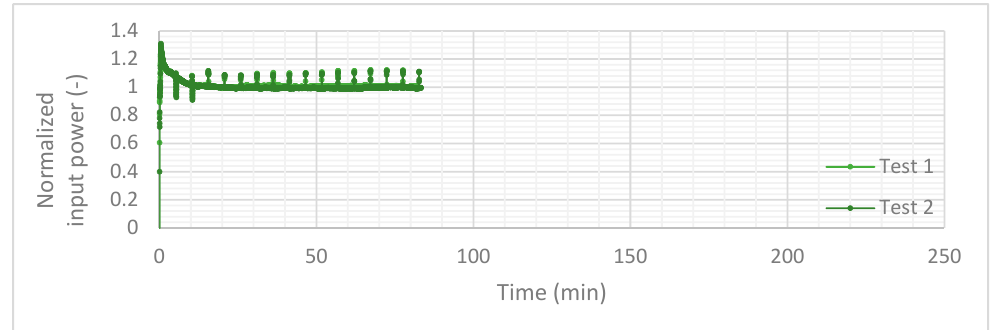
Figure A11. Normalized input power to the air compressor unit at the thermostatic temperature of − 20 °C.